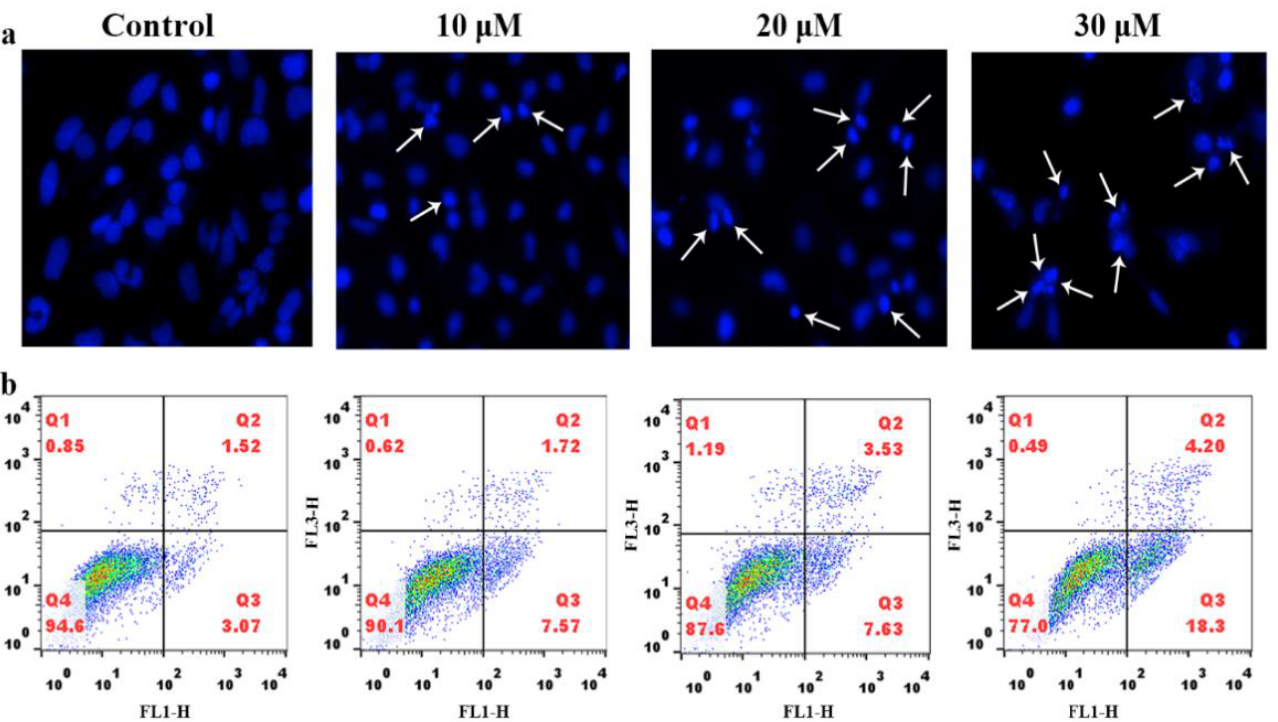
Figure 2. ( a ) DAPI nuclear staining of HeLa cells treated with different concentrations of compound 3a for 24 h. ( b ) Apoptosis rate of HeLa cells was detected using flow cytometry after HeLa cells were treated with different concentration of compound 3a for 24 h.